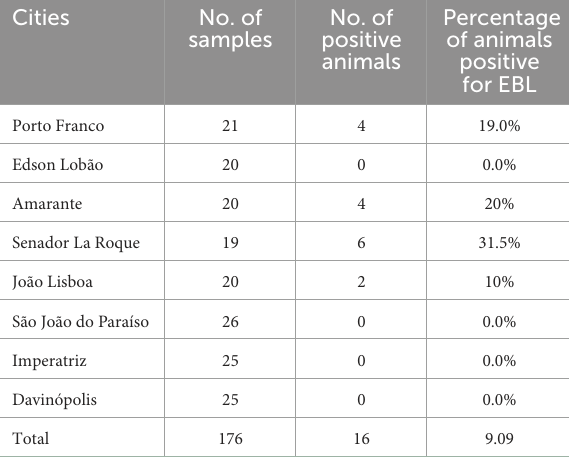
TABLE 1 Percentage of animals positive for BLV by cities in the Southwest region of Maranhão. Cities No. of